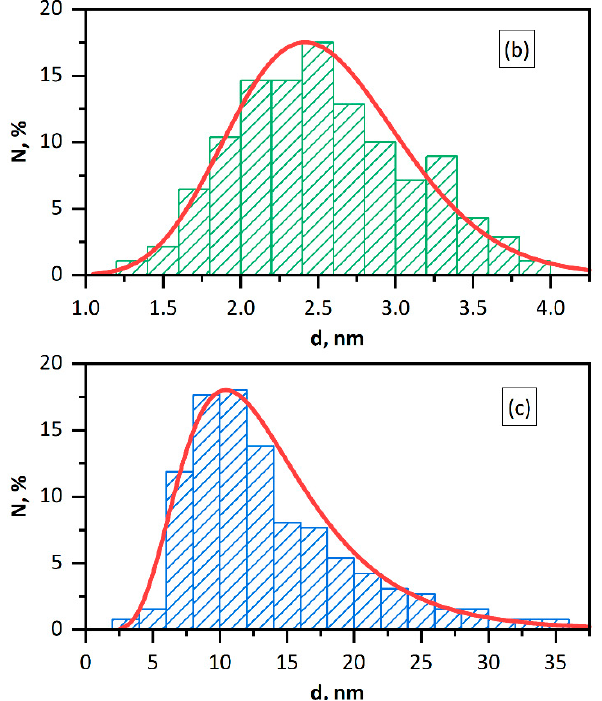
Figure 1. TEM image of Pd NPs ( a ). Size distribution of Pd NPs according to TEM ( b ) and DLS ( c ) data. Solution: [ Pd 0 ] = 0.20 mM, [PANa] = 10.0 mM.